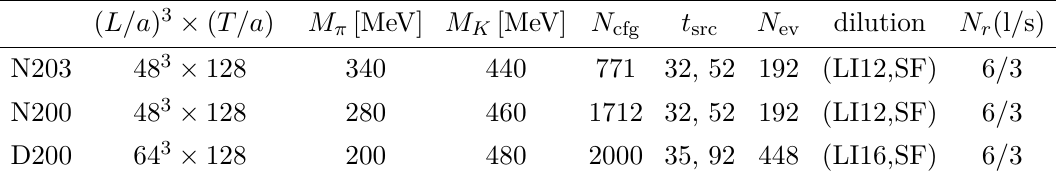
Table 1. Overview of the lattice geometry, approximate pseudoscalar masses, number of gauge configurations N cfg , fixed source-time positions t src , number of Laplacian eigenvectors N ev , employed dilution scheme, and number of independent quark noises N r used to estimate light and strange quark propagation for ensembles used in this work. The dilution scheme notation is explained in ref. [11]. All ensembles share the same lattice spacing a ≈ 0 . 064 fm .